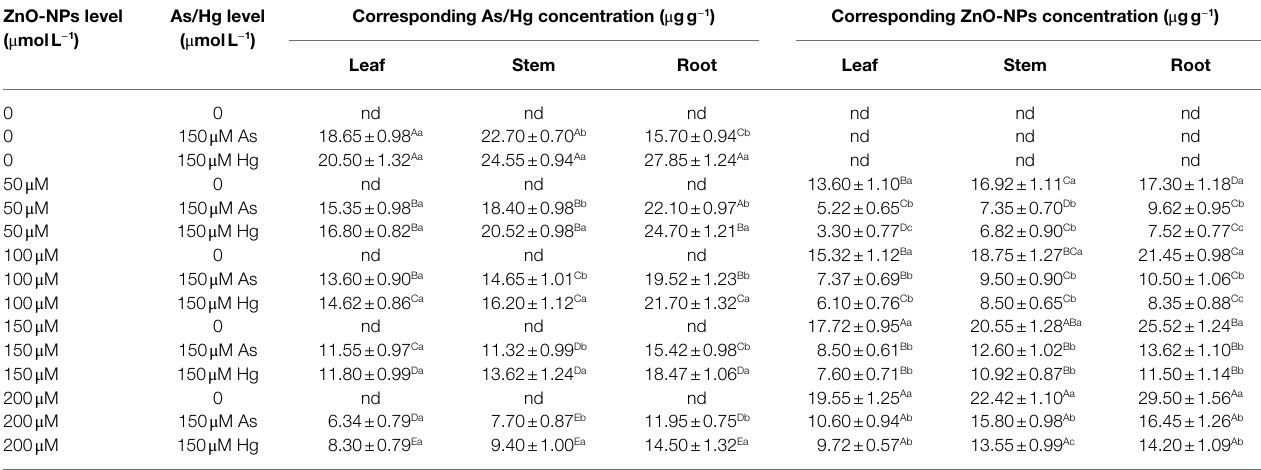
Each data point is the mean ± SE of four replicates. The treatments included four levels of ZnO-NPs (50, 100, 150, and 200 μ M) alone and in combination with 150 μ M As and 150 μ M Hg. The capital letters indicated statistically significant differences across various levels of ZnO-NPs alone or in combination with 150 μ M As and 150 μ M Hg, while the lowercase letters displayed statistically significant differences within each level of ZnO-NPs alone and in combination with 150 μ M As and 150 μ M Hg based on Tukey’s test (p < 0.05). They are superscripted on top of the numbers. nd, not detected.